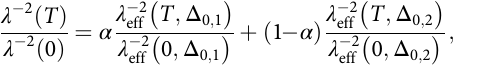
Fig. 4 Pressure evolution of the penetration depth for MoTe 2 . Colored symbols represent the value of λ (cid:2) 2 applied magnetic fi eld of μ 0 H = 20 mT under the applied hydrostatic pressures indicated in each panel. The solid lines correspond to a 2-gap s -wave model, the dashed and the dotted lines represent a fi t using a 1-gap s -wave and nodal gap models, respectively. The error bars are calculated as the